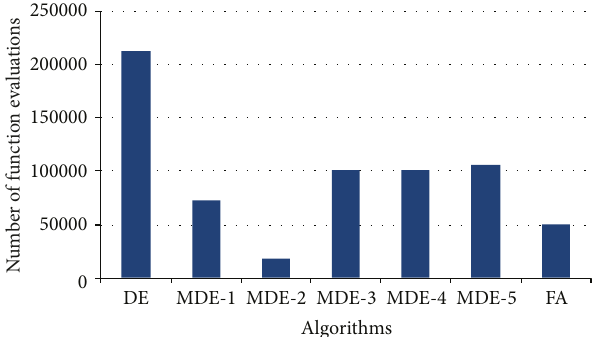
Figure 6: The number of function evaluations done by different algorithms to solve the 6-bus model.